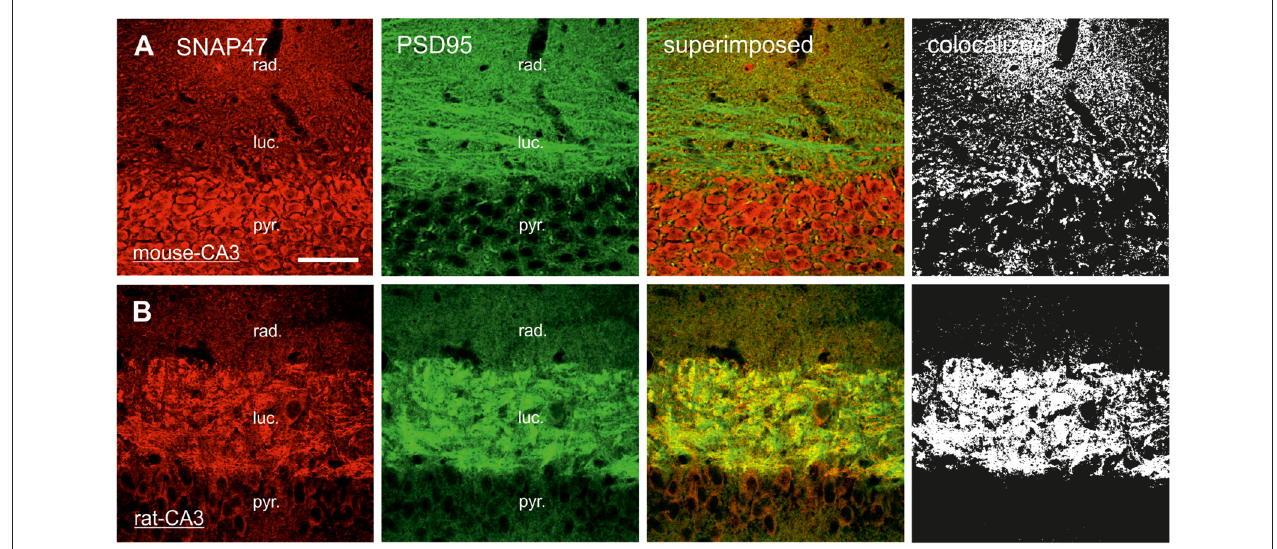
FIGURE 9 | Postsynaptic localization of SNAP47 in the CA3 area of mouse and rat hippocampus. (A) Confocal images of the double immunolabeling for SNAP47 (red pseudocolor) and the postsynaptic marker PSD95 (in green) in the CA3 area of the mouse hippocampus. Stratum lucidum and radiatum show weak labeling for both SNAP47 and PSD95. Weak co-localization is observed in these two layers (see the superimposed signals and the colocalization on the rigth). (B) Double immunolabeling for SNAP47 and postsynaptic marker PSD95 in the CA3 area of the rat hippocampus. Stratum lucidum shows strong overlap of SNAP47 and PSD95. Scale bar represent, (A,B) , 50 µ